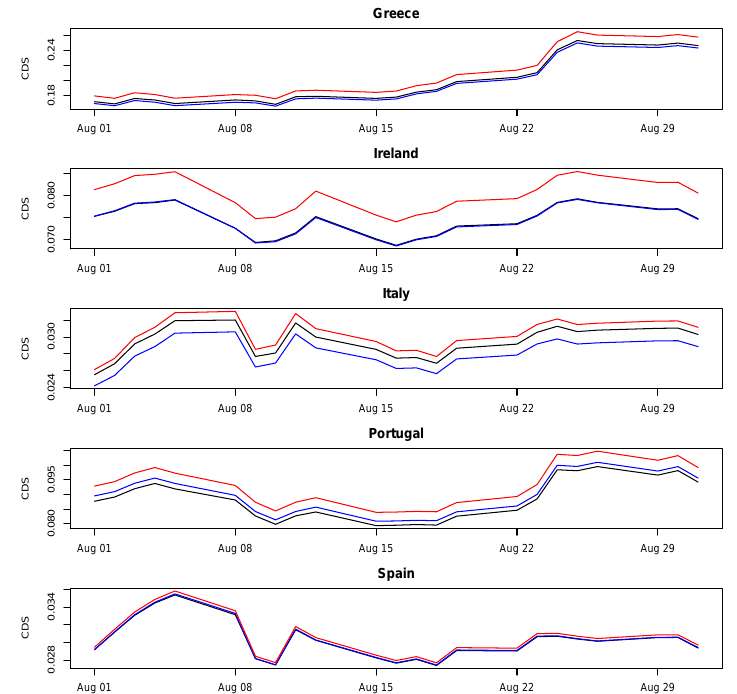
Figure 5. August 2011, predictive performance for peripheral countries. For each considered peripheral country, the graphs report the observed CDS spreads at time t (black line), the CDS spreads predicted at time t − 1 using the proposed model (red line) and the CDS spreads predicted at time t − 1 using only the autoregressive component (blue line).